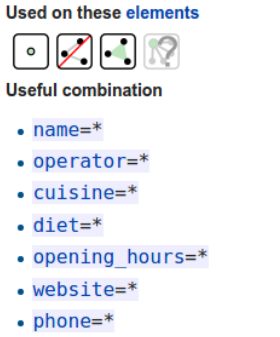
Figure 1. In this screenshot from the Map Features page for amenity=restaurant , a number of suggested tag keys which could be combined with this tag are